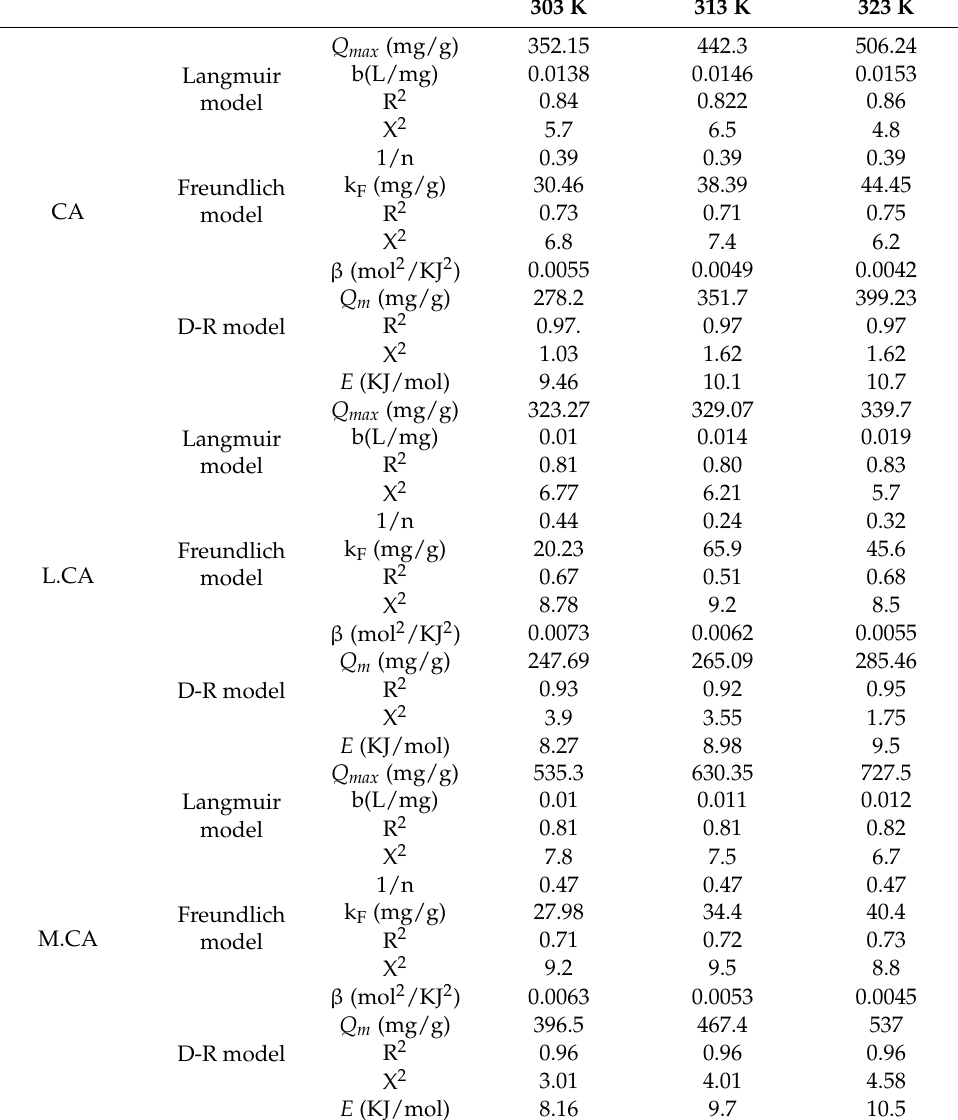
Table 2. The mathematical parameters of the studied classic isotherm